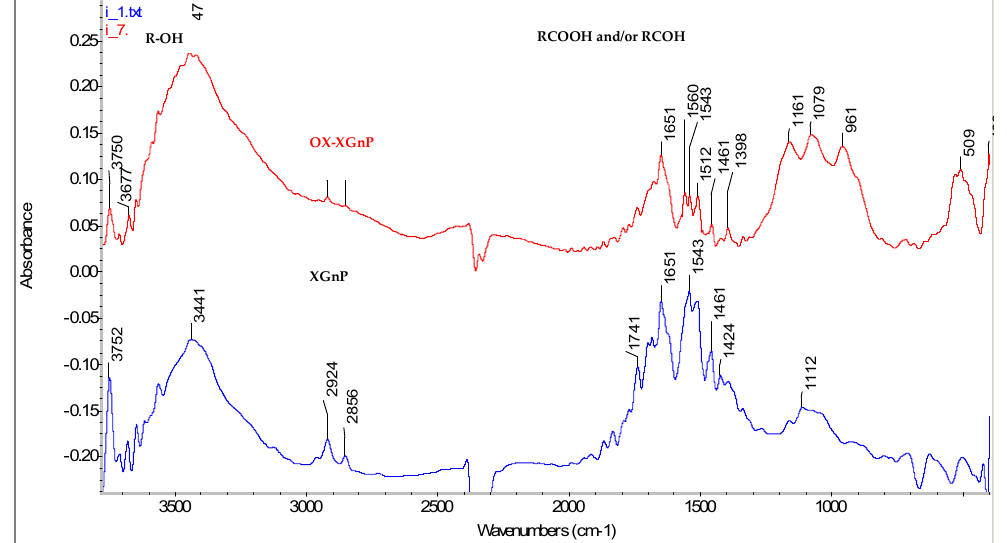
Figure 3. Fourier transformation infrared (FTIR) spectra of as-prepared (blue line) and oxidized xGnP (red line). The absorption spectra showed peaks at 3441 cm − 1 for xGnP and 3447 cm − 1 for ox-xGnP, which corresponded to hydroxyl groups HO- from atmospheric natural humidity, these peaks increasing after the oxidation process. After the HNO 3 treatment, characteristics peaks at 2904 cm − 1 for xGnP and 2918 cm − 1 for ox-xGnP are provided by the presence of symmetric and asymmetric -CH 2 groups. The evidence of -COOH group formation is demonstrated by the new peak appearing at 1161 cm − 1 for ox-xGnP, corresponding to C-O stretching and at 1398 cm − 1 coming from the intermediate oxidation products and H-O- bending vibrations. The peak at 1560 cm −1 corresponds with C=O groups in ox-xGnP.